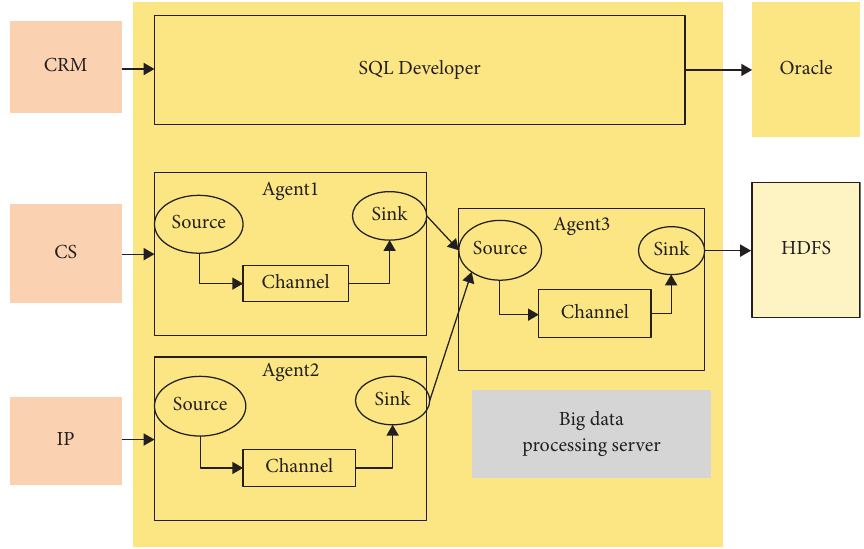
Figure 2: Design of the user data acquisition